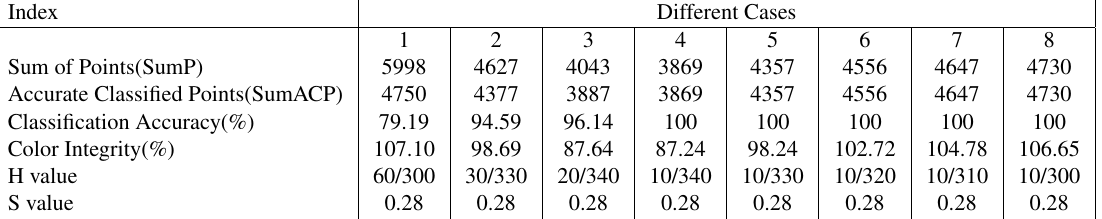
Table 1: Data to find the best threshold in HSV space